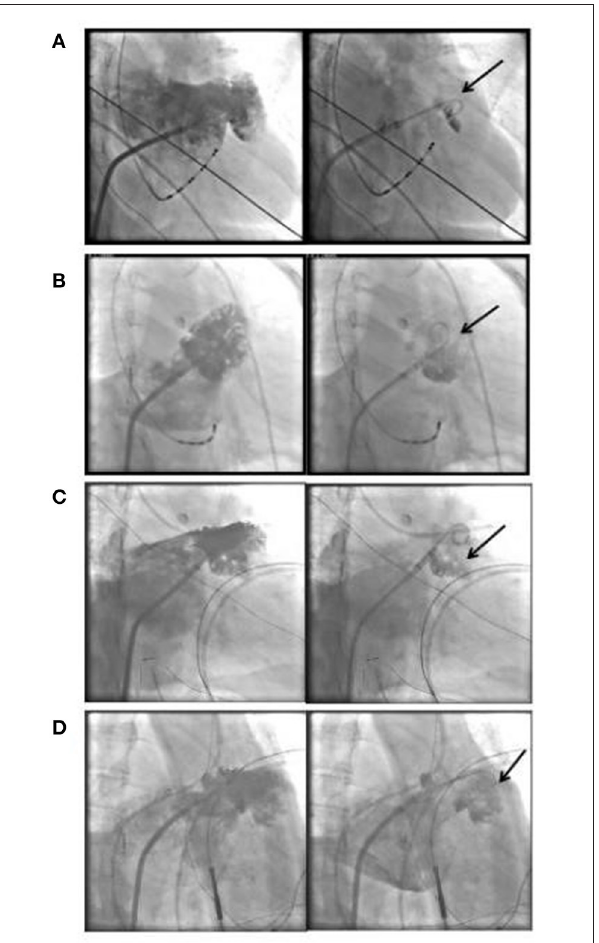
FIGURE 3 | Illustration of LAA angiography image and contrast agent retention. Chicken Wing type LAA and contrast agent retention (A) , Cauliflower type LAA and contrast agent retention (B–D) , the arrows indicate contrast agent retention. LAA, left atrial